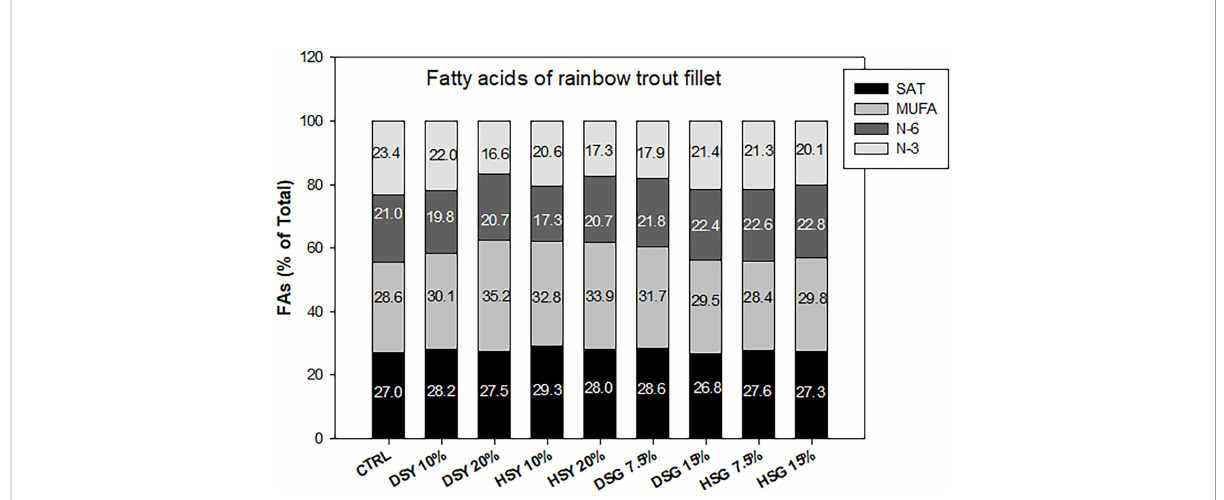
FIGURE 1 Fatty acid composition of the muscle of rainbow trout fed with the experimental diets. SAT, saturated; MUFA, monounsaturated; N-3, omega-3; N-6, omega-6 fatty acids.